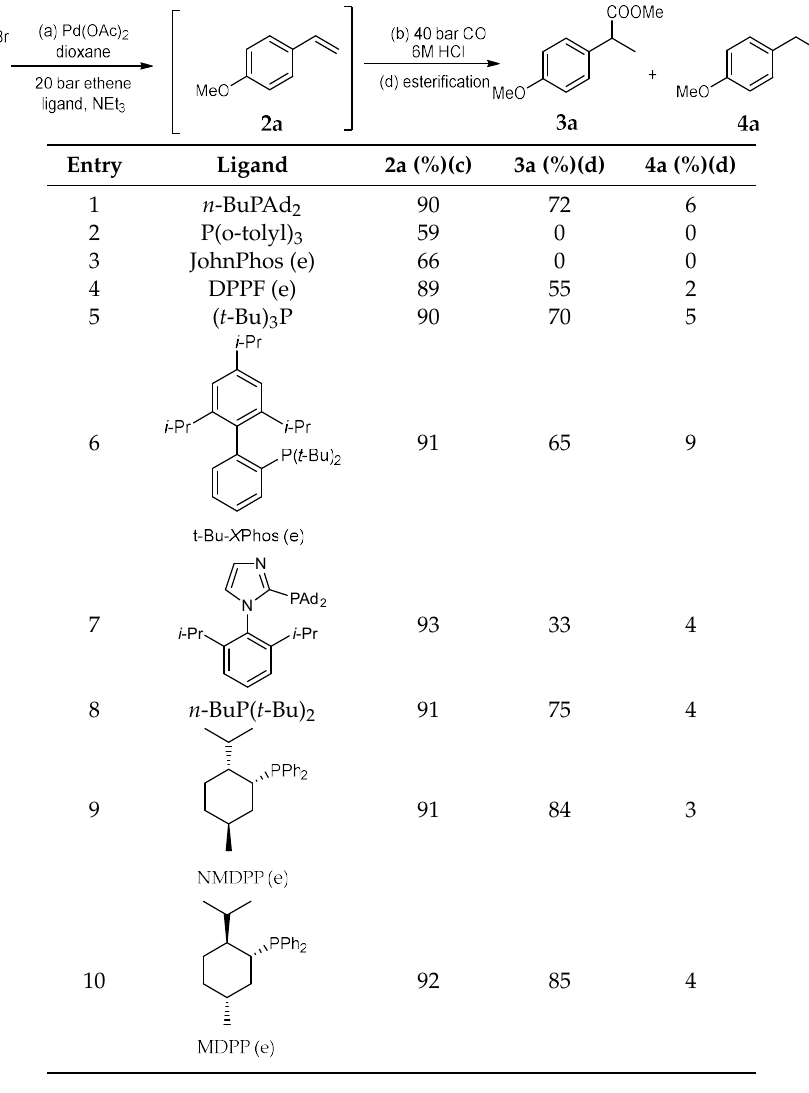
Table 1. Palladium-catalyzed two-step synthesis for 2-aryl propionic acid 3a .